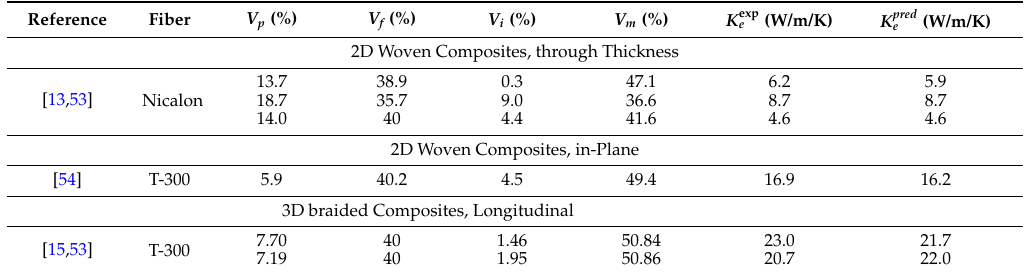
Table 13. Measured thermal conductivities and calculated values of CVI-deposited composites.